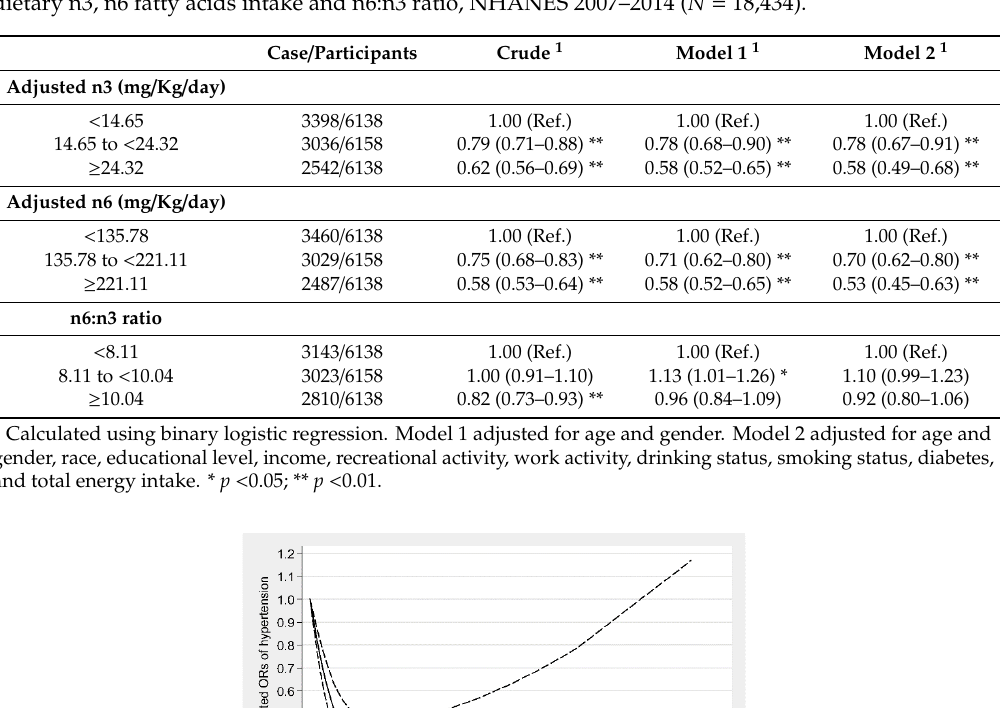
Table 2. Weighted odds ratios (95% confidence intervals) of hypertension across tertiles of adjusted dietary n3, n6 fatty acids intake and n6:n3 ratio, NHANES 2007–2014 ( N = 18,434).